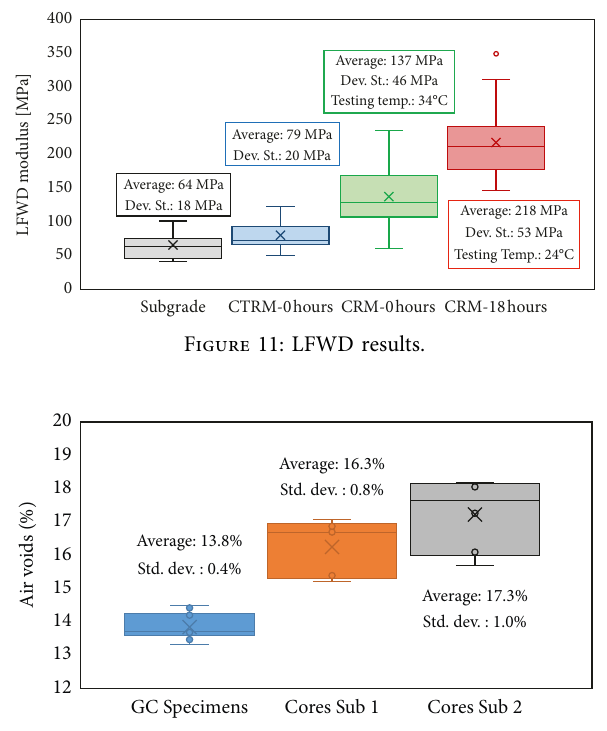
Figure 12: Voids of the GC specimens and field cores.